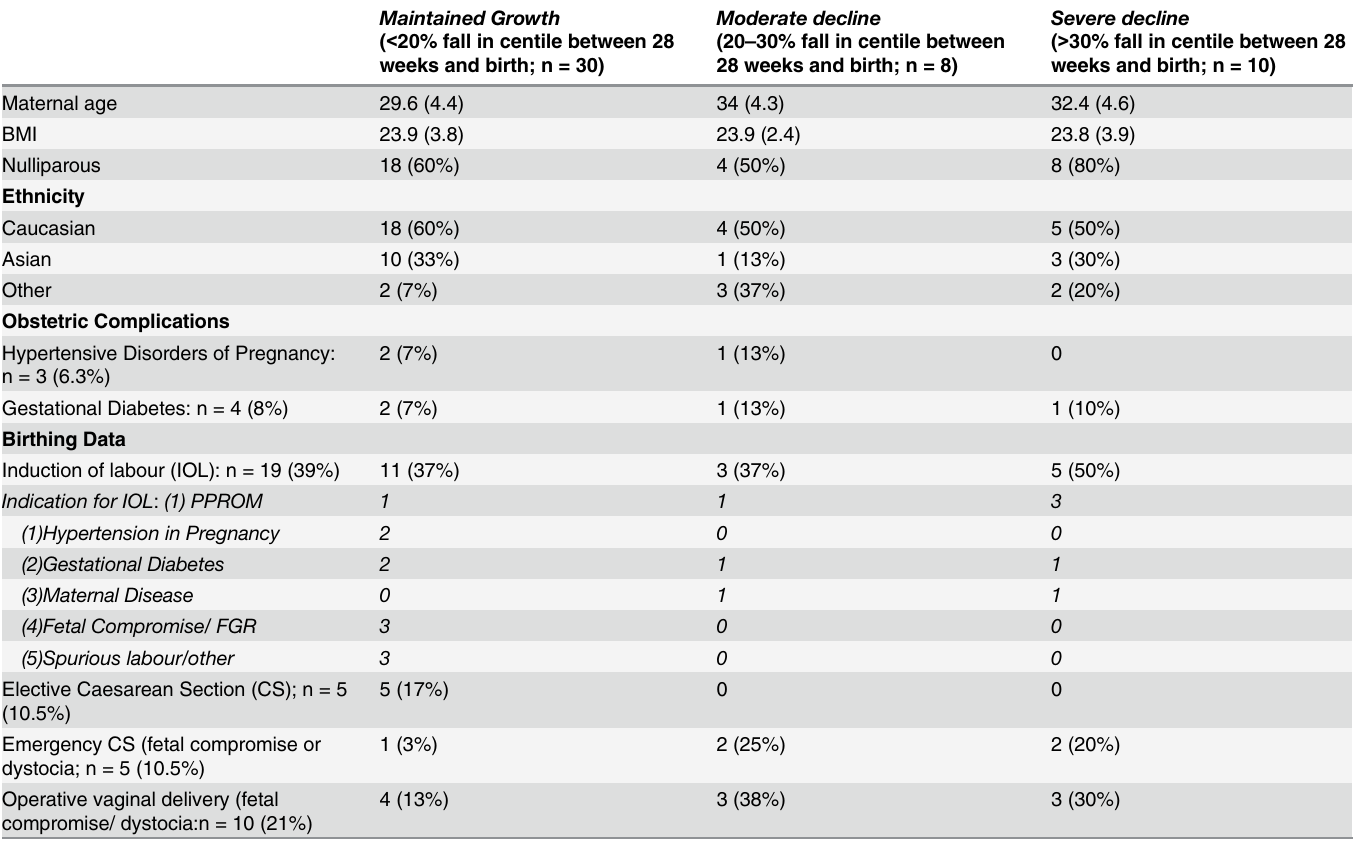
Table 1. Patient demographic and delivery details according to change in growth